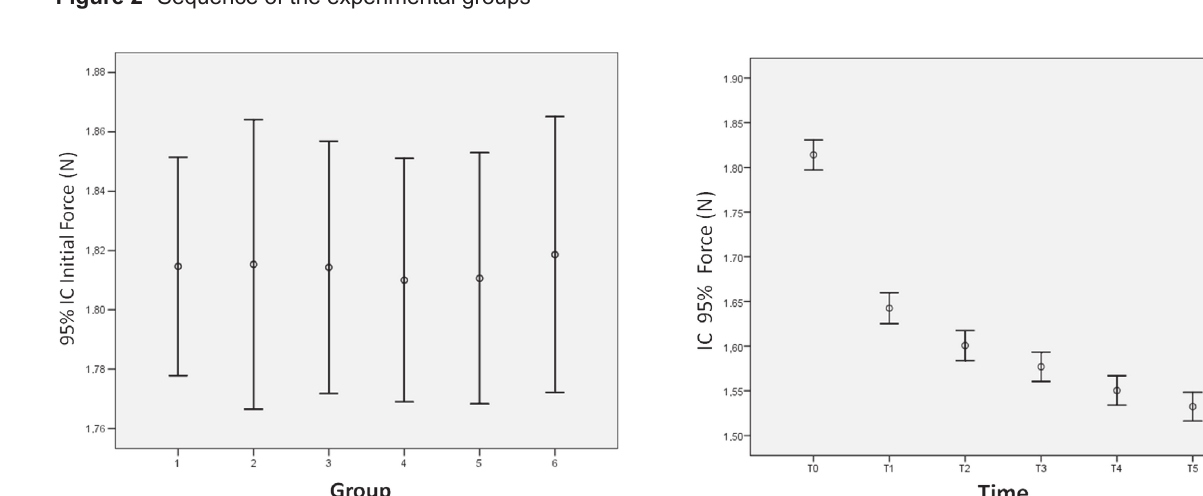
Figure 2- Sequence of the experimental groups